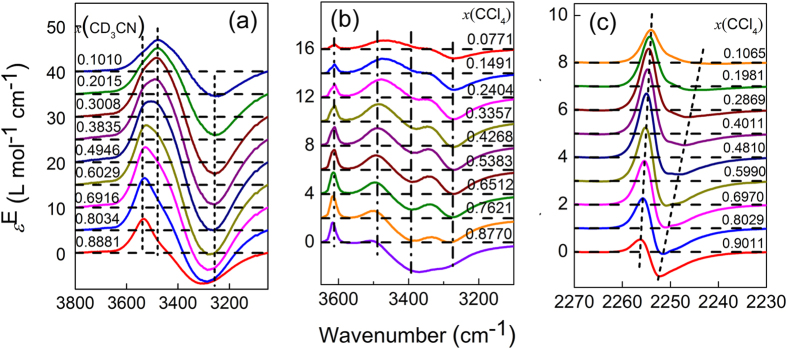
Excess infrared spectra.(a) O–H stretching in C2H5OH−CD3CN system13. (b) O–H stretching in tert-butanol–CCl4 system10. (c) C ≡ N stretching in CD3CN–CCl4 system. Mole fractions of the binary mixtures have been indicated by the respective curves in the figure.